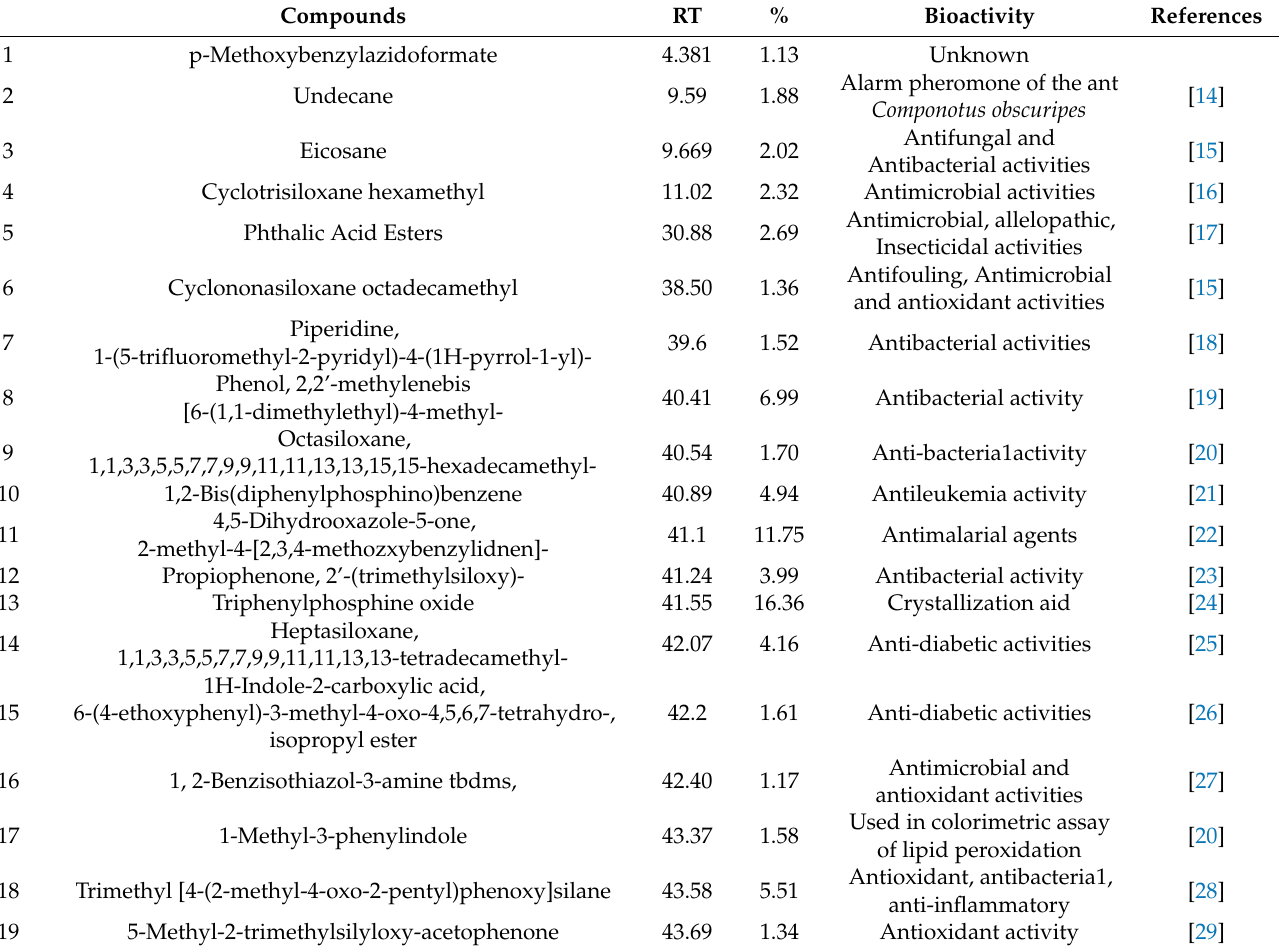
Table 1. Activity of phytocomponents identified in the methanolic extract of M. oblongifolia leaf.